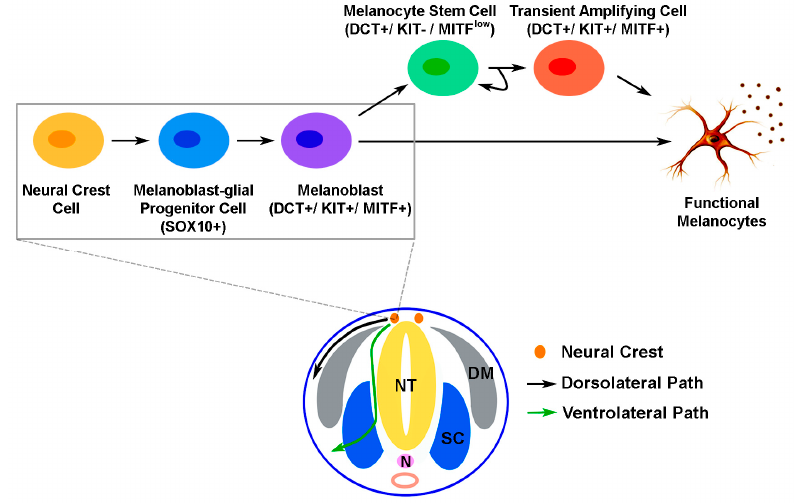
Figure 1. A schematic illustration of the migratory paths of neural crest cells and melanocyte development in a developing mammalian embryo. Cells that migrate from the trunk neural crest through the developing embryo may take a dorsolateral or ventrolateral path. Melanocytic differentiation from trunk neural crest cells begins with the specification of neural crest cells into melanoblast-glial progenitor cells which express SRY (sex determining region Y)-box 10 (SOX10). These progenitor cells are then committed into melanoblasts with the expression of dopachrome tautomerase (DCT), tyrosine protein kinase KIT (KIT) and microphthalmia-associated transcription factor (MITF). The melanoblast progenitor cells typically migrate along the dorsolateral path between the epidermis and dermomyotome. During embryogenesis, melanoblasts can move into embryonic hair follicles where some melanoblasts continue to differentiate into functional melanocytes that produce melanin and participate in the initial hair cycle. Subsets of melanoblasts become melanocyte stem cells (McSCs), which have the capacity of self-renewal. McSCs remain quiescent until activated in the next hair cycle, resulting in transient amplifying cells and their subsequent differentiation into functional melanocytes. NT: neural tube, N: notochord, DM: